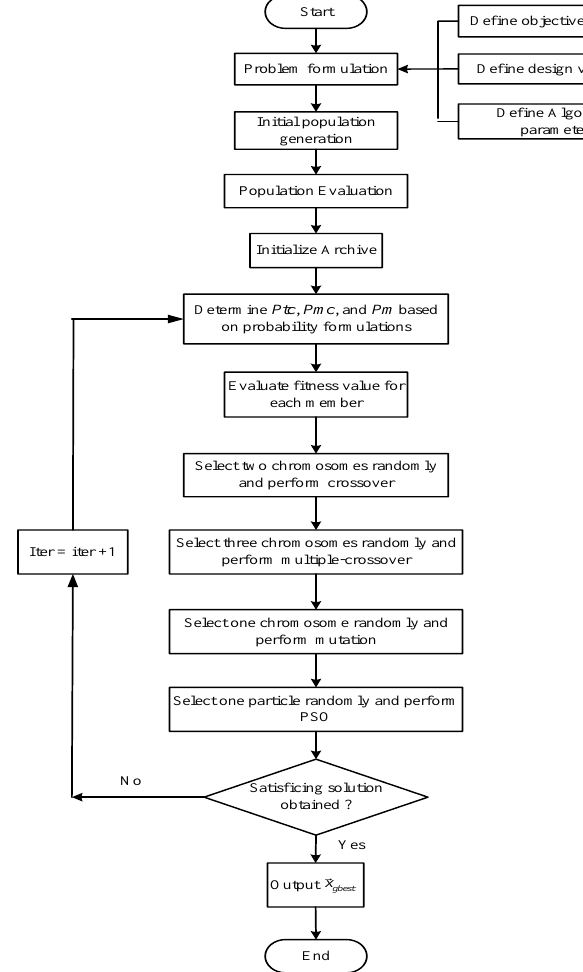
Figure 3. GA-PSO based multi objective optimization